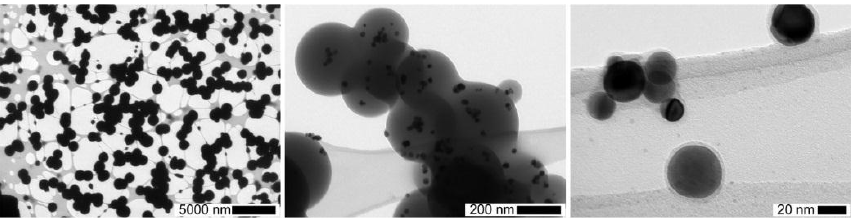
Figure 6. TEM micrographs: ( left ) Large SiO x particles (1.13 µm) formed in the gas phase during the reaction duration in the 20 L tank ( U pp = 10 kV, with post-DBD injection of c TEOS = 1400 ppmv without Pt nanoparticles); ( middle ) smaller sub-micron sized SiO x coated Pt particles, formed and agglomerated in the gas phase ( U pp = 8.6 kV, 20 L tank with 280 ppmv TEOS and Pt nanoparticles); and ( right ) nanometer thick coatings of Pt nanoparticles ( U pp = 8 kV, t Reaction = 185 s with 0.4 ppmv TEOS).